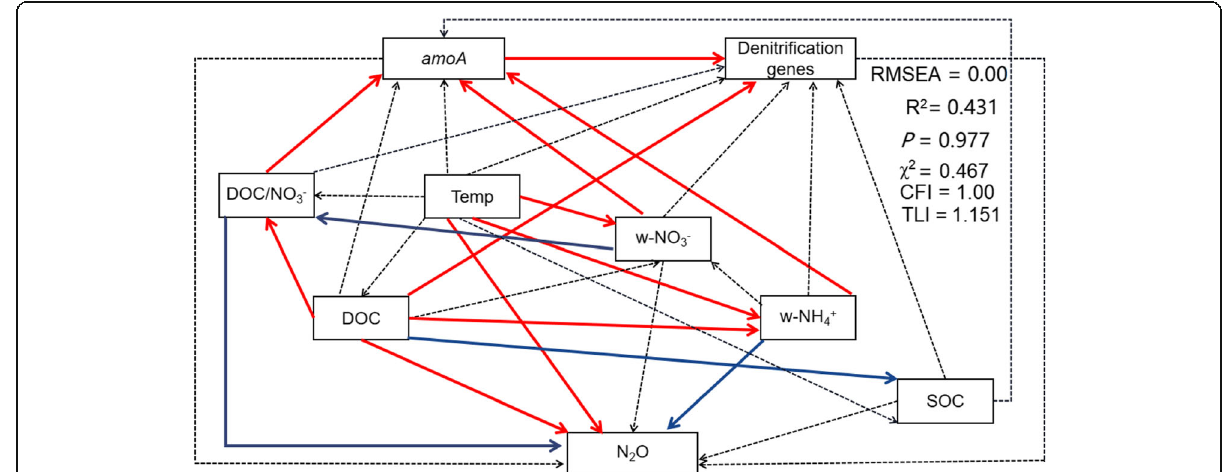
Fig. 5 SEM estimating the direct and indirect effects of physicochemical variables and functional genes on N 2 O concentration. The amoA in this figure is the principal component 1 (PC1) extracted from two nitrification genes. The denitrification genes in this figure are the PC1 extracted from three denitrification genes. Direct effect: the direct influence of explanatory variables on N 2 O concentration, and the value is the path coefficient from cause variable to result variable. Indirect effect: the influence of explanatory variables on N 2 O concentration through one or more mediating variables. The value is the product of the path coefficients starting from the explanatory variables and ending at the N 2 O concentration through all intermediary variables. Red solid lines demonstrate significantly positive effects ( P < 0.05), blue solid lines demonstrate significantly negative effects ( P < 0.05), and black dashed lines indicate insignificant effects. Single-headed arrows refer to